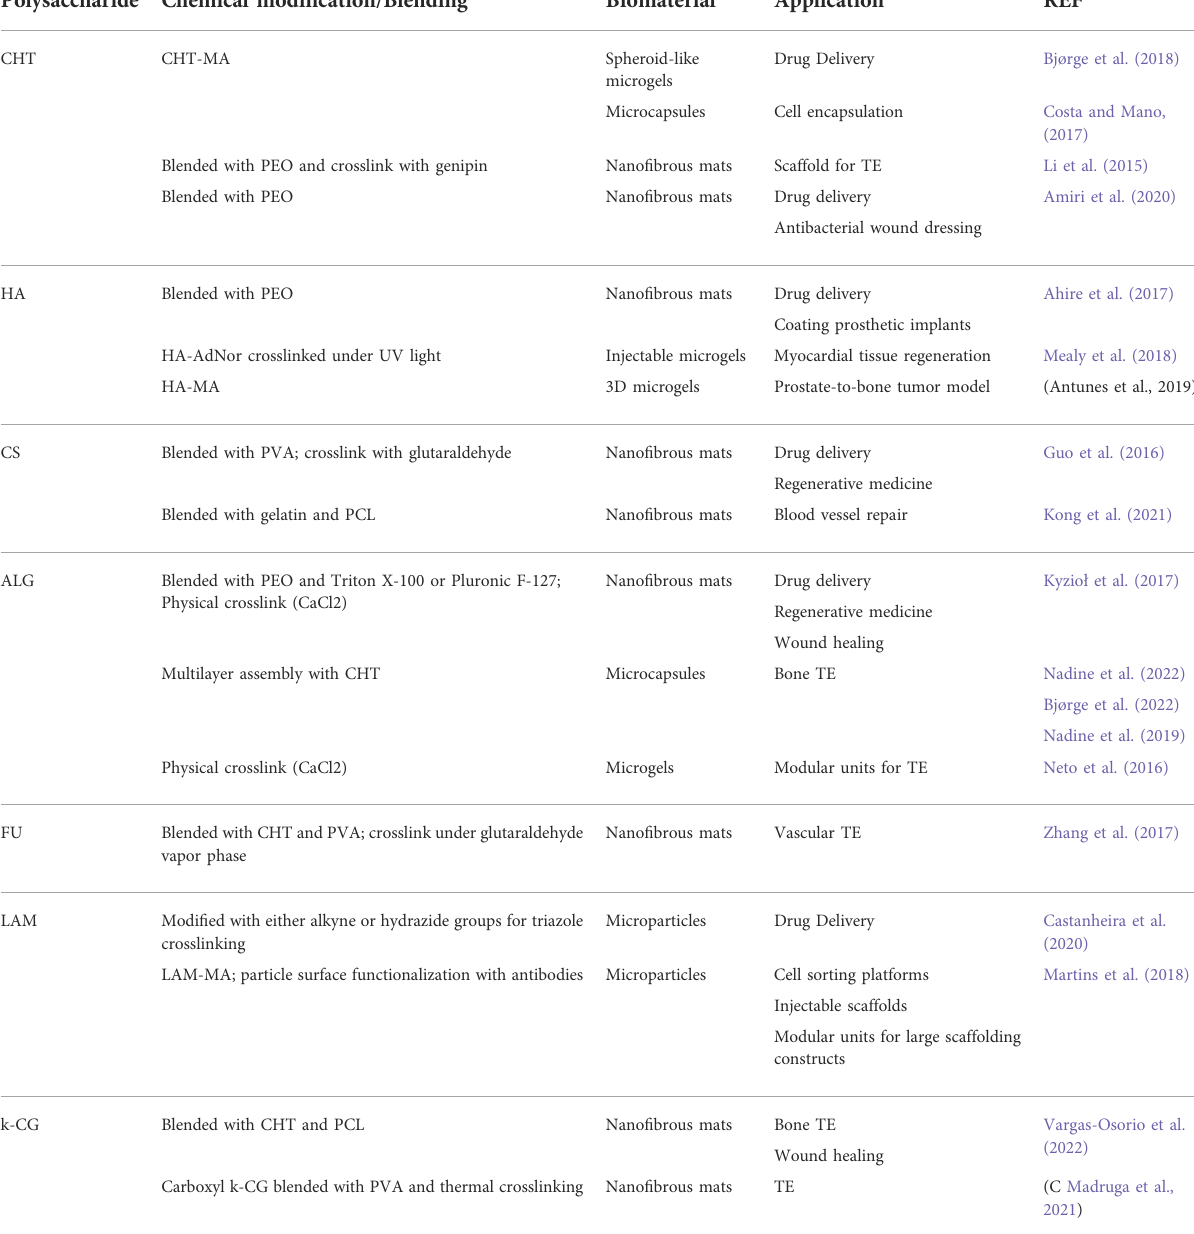
TABLE 3 Marine-derived polysaccharides and their processing as fi ber/particulate systems for biomedical